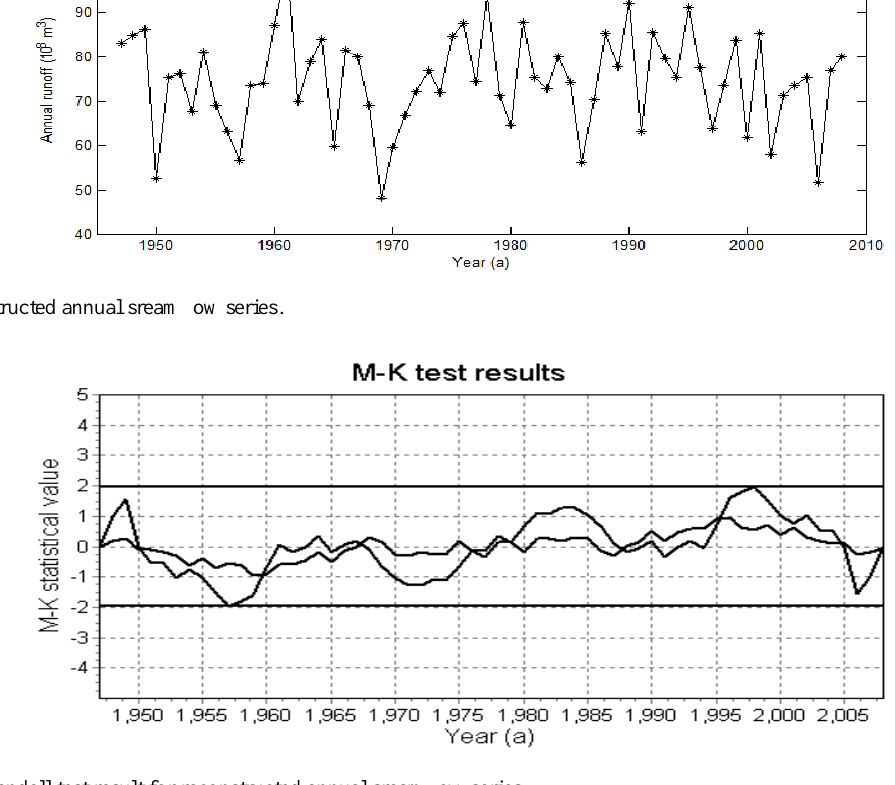
Figure 3. Man–Kendell test result for reconstructed annual sreamflow